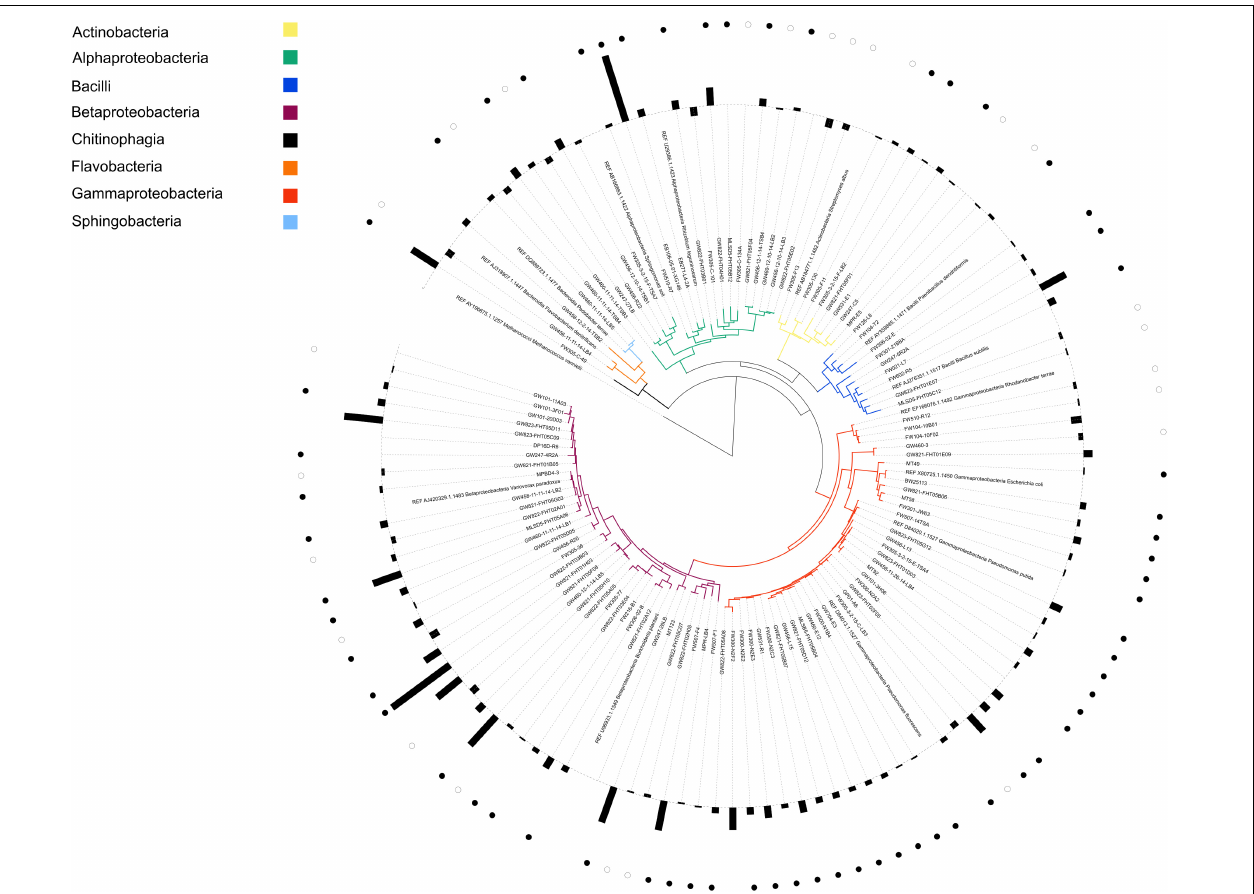
FIGURE 1 | Phylogenetic tree of all isolates with corresponding ratio of growth in NLDM and R2A. Label colors indicate the phylogenetic origin of each isolate by class. REF indicates reference organism and were inserted for guidance and not used in this study. Bars on the outer circle indicate the average ( n = 2 or n = 3) log2 ratio of the growth (maximum OD 600 ) of each isolate grown in NLDM and R2A. Ratios > 0 indicate that growth on NLDM was higher than in R2A and ratios < 0 indicate that growth in R2A was higher than in NLDM. Closed circles indicate that growth was significantly ( P < 0.05) higher in NLDM compared to R2A; open circles indicate that growth was significantly ( P < 0.05) higher in R2A compared to NLDM (pairwise t -test). All growth data (OD 600 values over time for all isolates) can be found in Supplementary Tables 7A–C . A phylogenetic tree including all reference and guide sequences is shown in Supplementary Figure 1